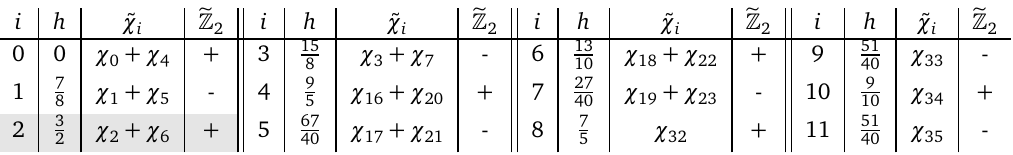
/ (cid:90) Table 23: SU ( 8 ) : primaries labeled by i are characterized by weights h . Their characters 2 2 ( τ ) are expressed in terms of the characters of SU ( 8 ) ˜ χ i the primary related to the (cid:101) (cid:90) 2